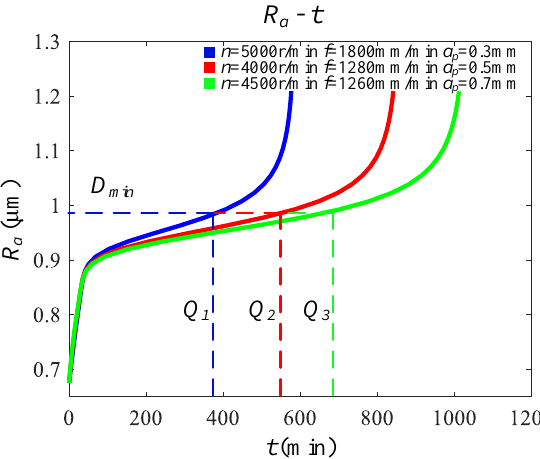
Figure 2. Tool milling quality life under different cutting conditions.